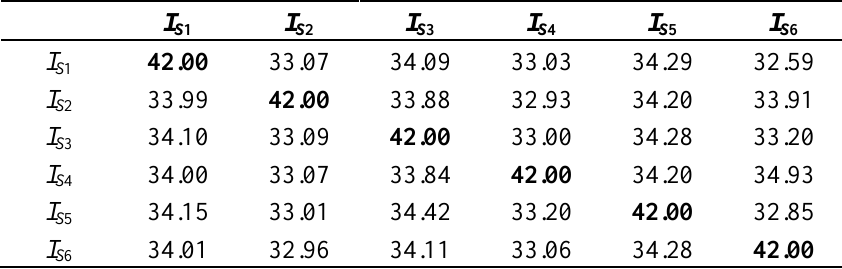
( peak ) for the images shown in Figure α